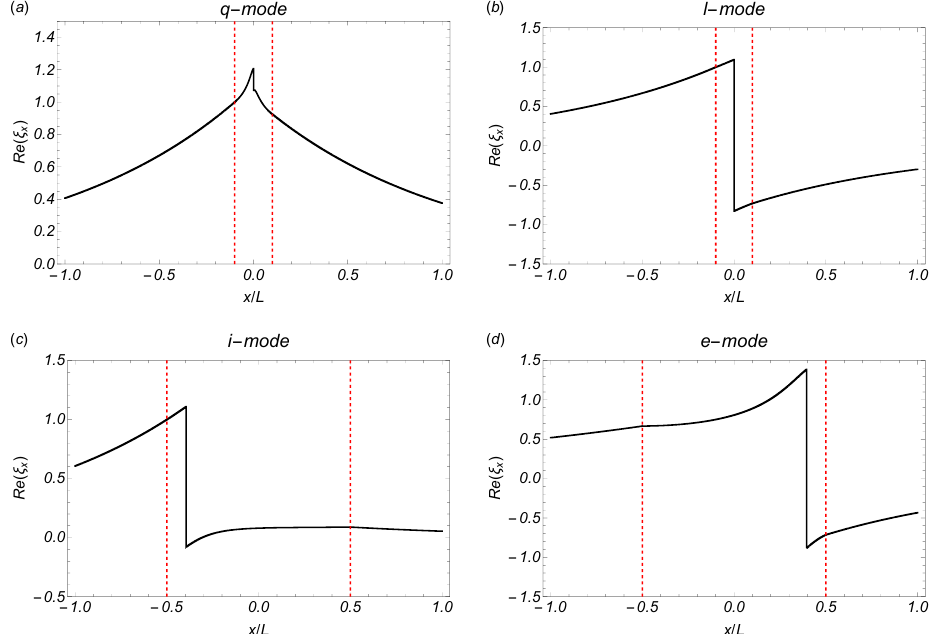
Figure 2. Real part of ξ x (in arbitrary units) of the solutions: ( a ) q-mode for kl = 0.2, ( b ) l-mode for kl = 0.2, ( c ) i-mode for kl = 1, and ( d ) e-mode for kl = 1. The two vertical dashed red lines denote the boundaries of the nonuniform region. ρ i / ρ e = 2, kL = 1, and k z L = 0.1 are used here, where L is a normalization length. See text for